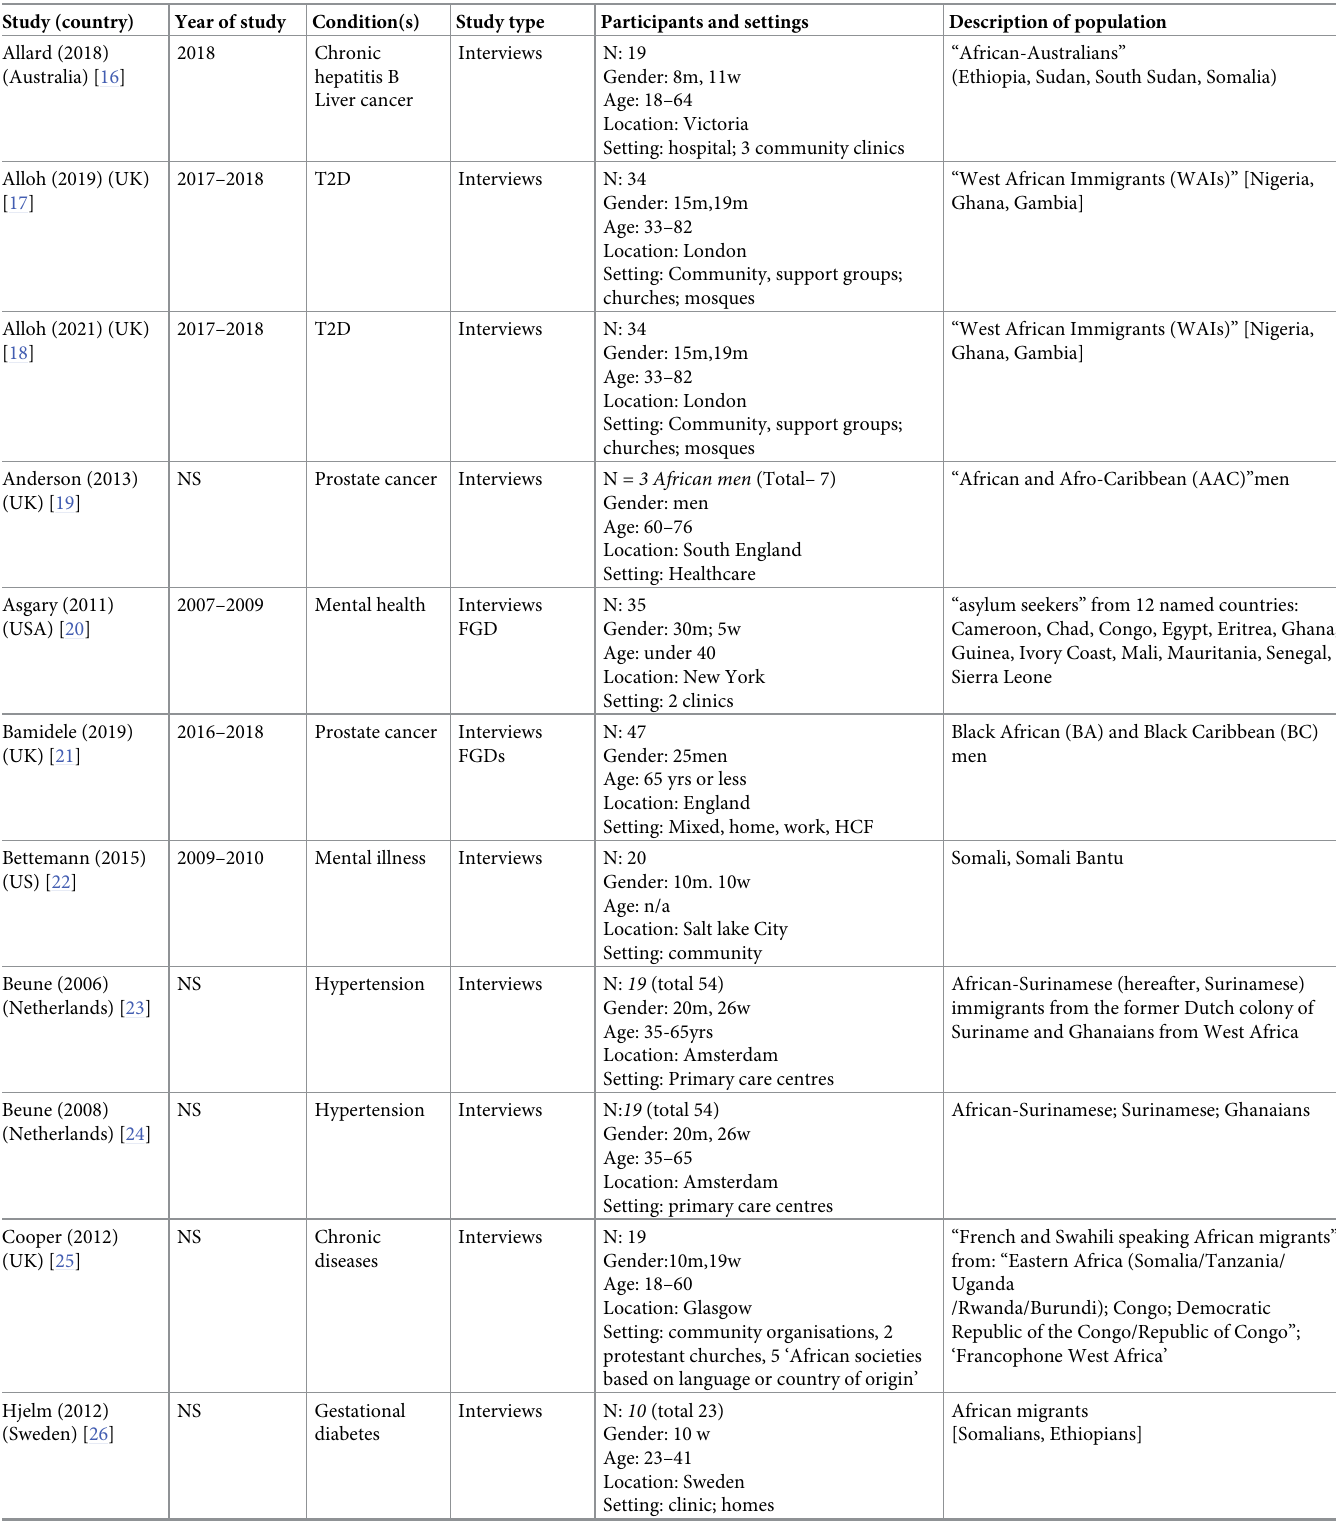
Table 1. Description of included